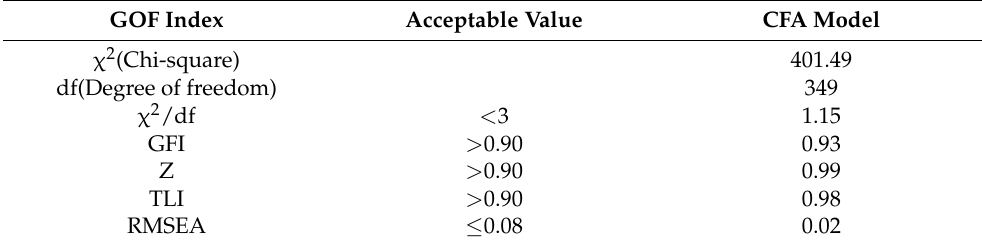
Table 1. CFA goodness of test (N = 350).